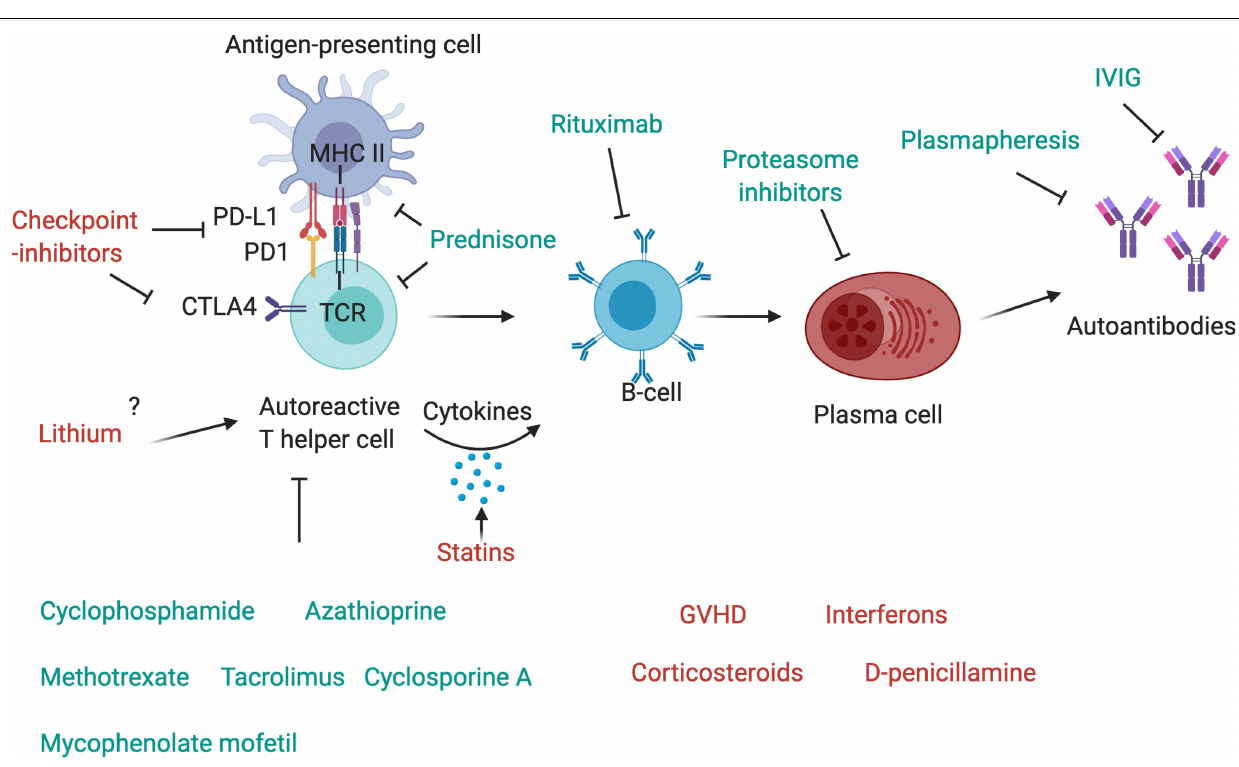
FIGURE 2 | Drugs affecting components of the immune system. The T-cell receptor (TCR) of autoreactive T-helper cells recognizes antigen peptides that are presented by the MHC II complex on antigen-presenting cells. The binding of programmed cell death protein 1 (PD-1) to its ligand, PD-L1, expressed, respectively, on antigen-presenting cell and T-cell, inhibits immune activation and is an important immune checkpoint to guard against autoimmunity. CTLA4 is another checkpoint that is expressed on regulatory T-cells and upregulated on conventional T cells after activation and turns off T-cell activation when it interacts with its ligands, CD80 or CD86, on antigen-presenting cells. Checkpoint inhibitors are used as therapy to stimulate an attack on tumor cells, but they may also activate autoreactive T-cells and induce autoimmunity. Corticosteroids such as Prednisone inhibit antigen processing and presenting in antigen-presenting cells and block T-cell activation in the nucleus. T-cells are further targeted by other immunosuppressant drugs, such as cyclophosphamide, azathioprine, methotrexate, mycophenolate mofetil, cyclosporin A or tacrolimus. T helper cells activate autoreactive B-cells via MHC II-antigen-TCR interaction and the secretion of pro-inflammatory cytokines, these may be increased by statins. B-cells can be depleted by the use of Rituximab, a therapeutic monoclonal antibody against CD20, which is beneficial in many antibody-mediated autoimmune diseases. Plasma cells, which produce autoantibodies, may be targeted by proteasome inhibitors, and autoantibodies can be depleted by plasmapheresis. IVIg are also a therapeutic drug in autoimmune diseases that ameliorate antibody-mediated effects, although their exact mechanism of action is